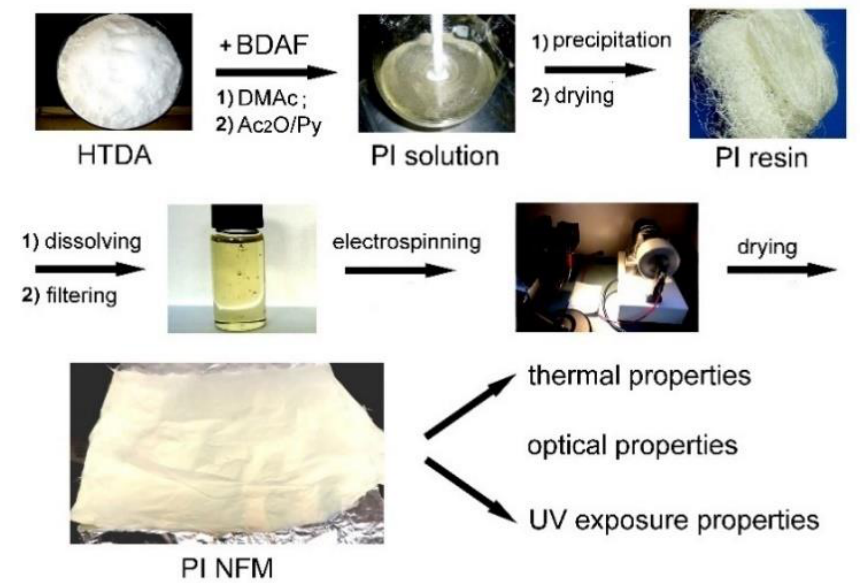
Figure 5. Preparation of PI NFM via electrospinning procedure from soluble PI resin.